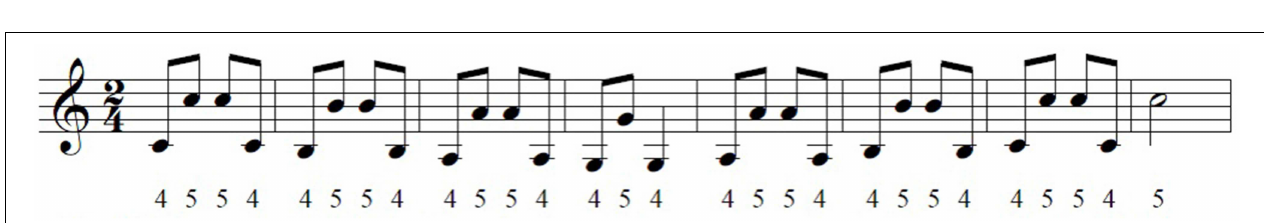
FIGURE 3 | The large-weak condition (LW): large hand span (i.e., fingers stretching across an octave) with only weak fingers, i.e., the ring (4) and little (5) fingers involved.